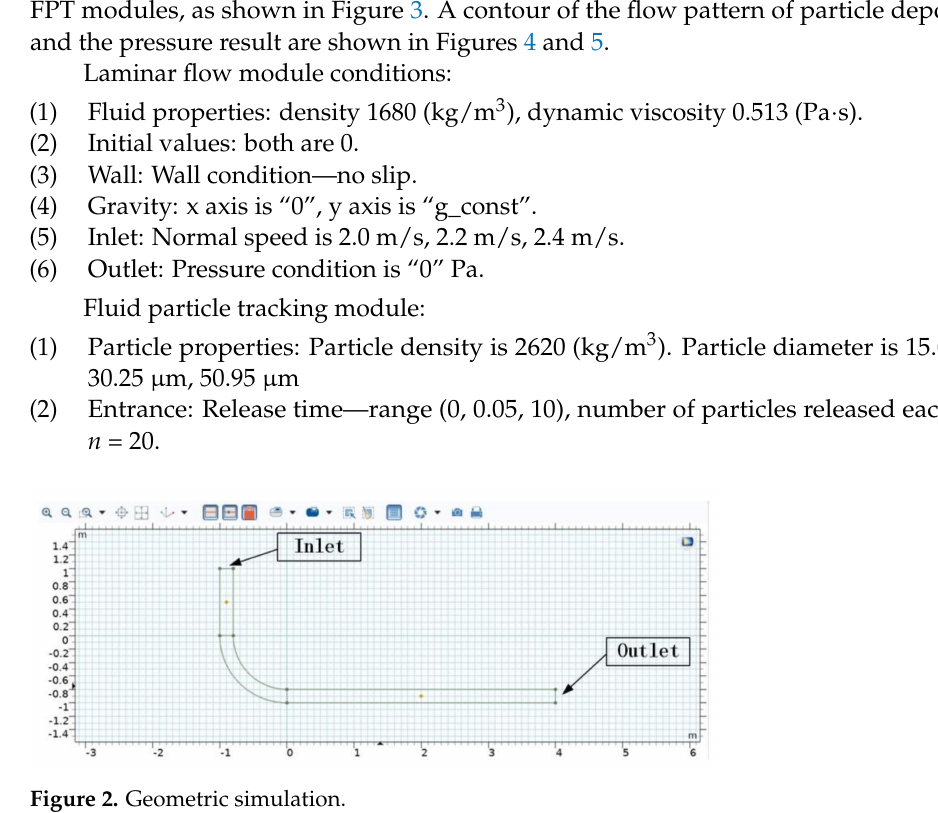
Figure 2. Geometric simulation.